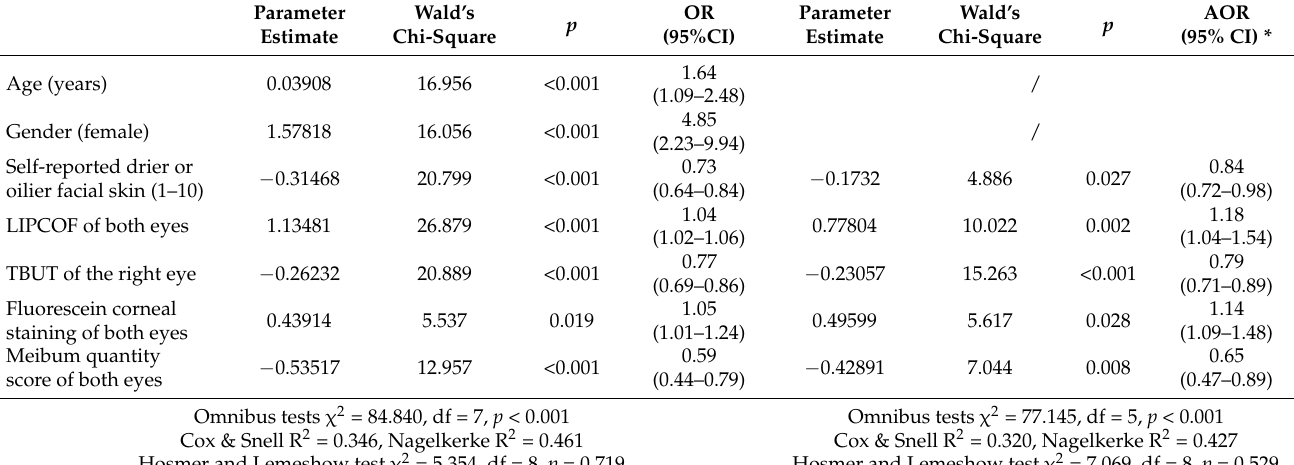
Table 3. Predictors and indicators of dry eye symptoms using binary logistic regression